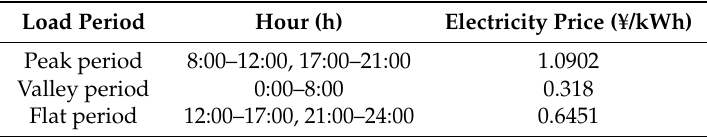
Table 2. Time of use electricity prices.